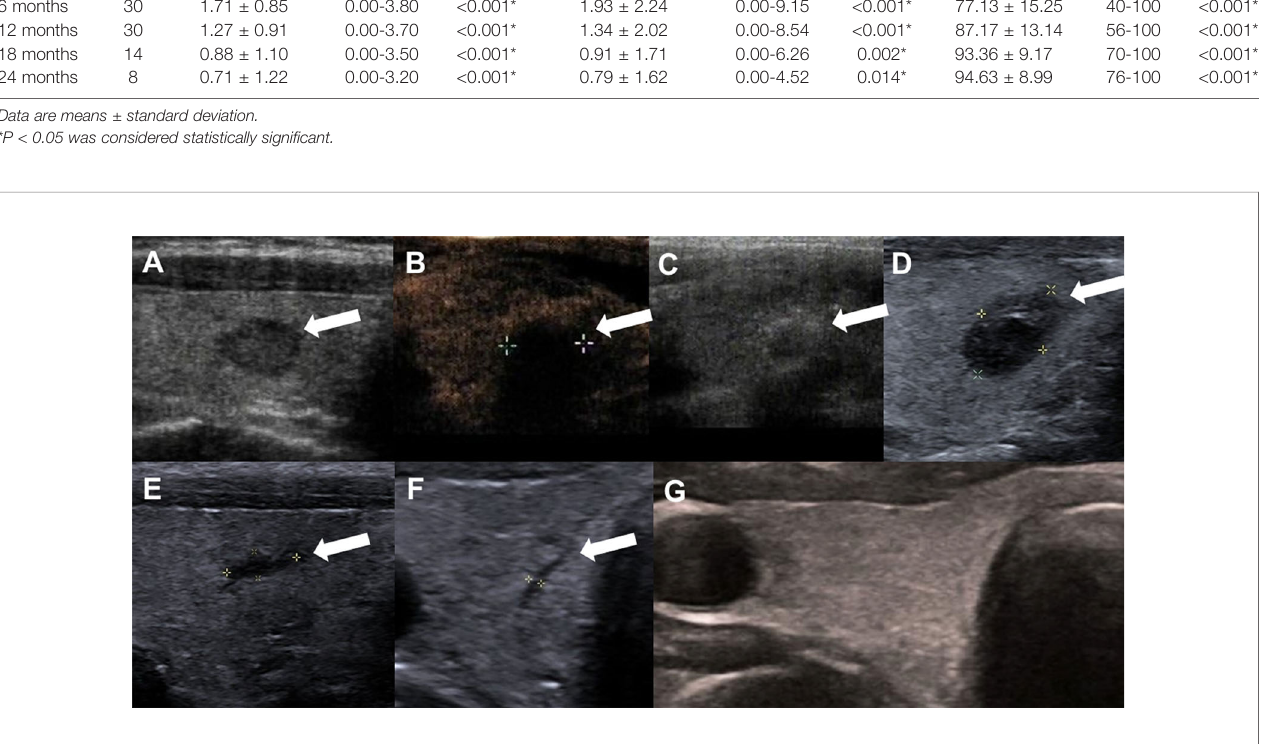
FIGURE 2 | A 47-year-old woman with Bethesda IV thyroid nodules on FNA in the right thyroid lobe. (A) Before RFA, ultrasound image shows a hypoechoic nodule with an smooth margin thyroid nodule, and size with 0.9cm×0.6 cm×0.6 cm; (B) Contrast-enhanced ultrasound performed immediately after RFA shows larger in size(1.2cm×1.1cm×1.1 cm) than that before ablation and a complete lack of enhancement in the treated area (white arrows). (C) Ultrasound shows gas formation in the nodule which covered by a hyperechoic ablation area (white arrows); (D) 1 month after ablation, the ablation zone was 0.9cm × 0.5cm × 0.6 cm in size; (E) 3 month after RFA, ultrasound shows the treated area shrunk (0.6cm×0.2cm×0.2cm); (F) 6 months after RFA, ultrasound shows line-like hypoechoic area, remained as a small scar lesion (white arrows); (G) The ablation area disappeared on ultrasonography 12 months after